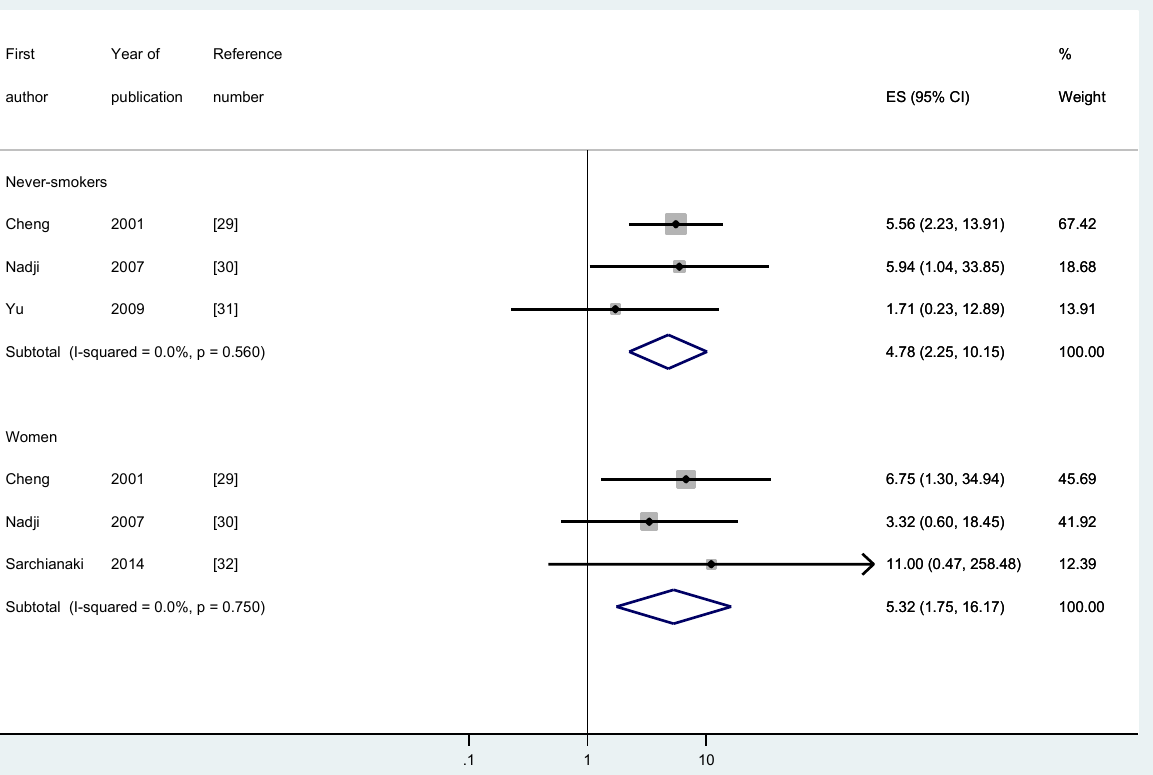
Figure 2. The forest plot of summary effect size (ES) with 95% confidence intervals (CI) using a fixed effect model by never-smokers and women.